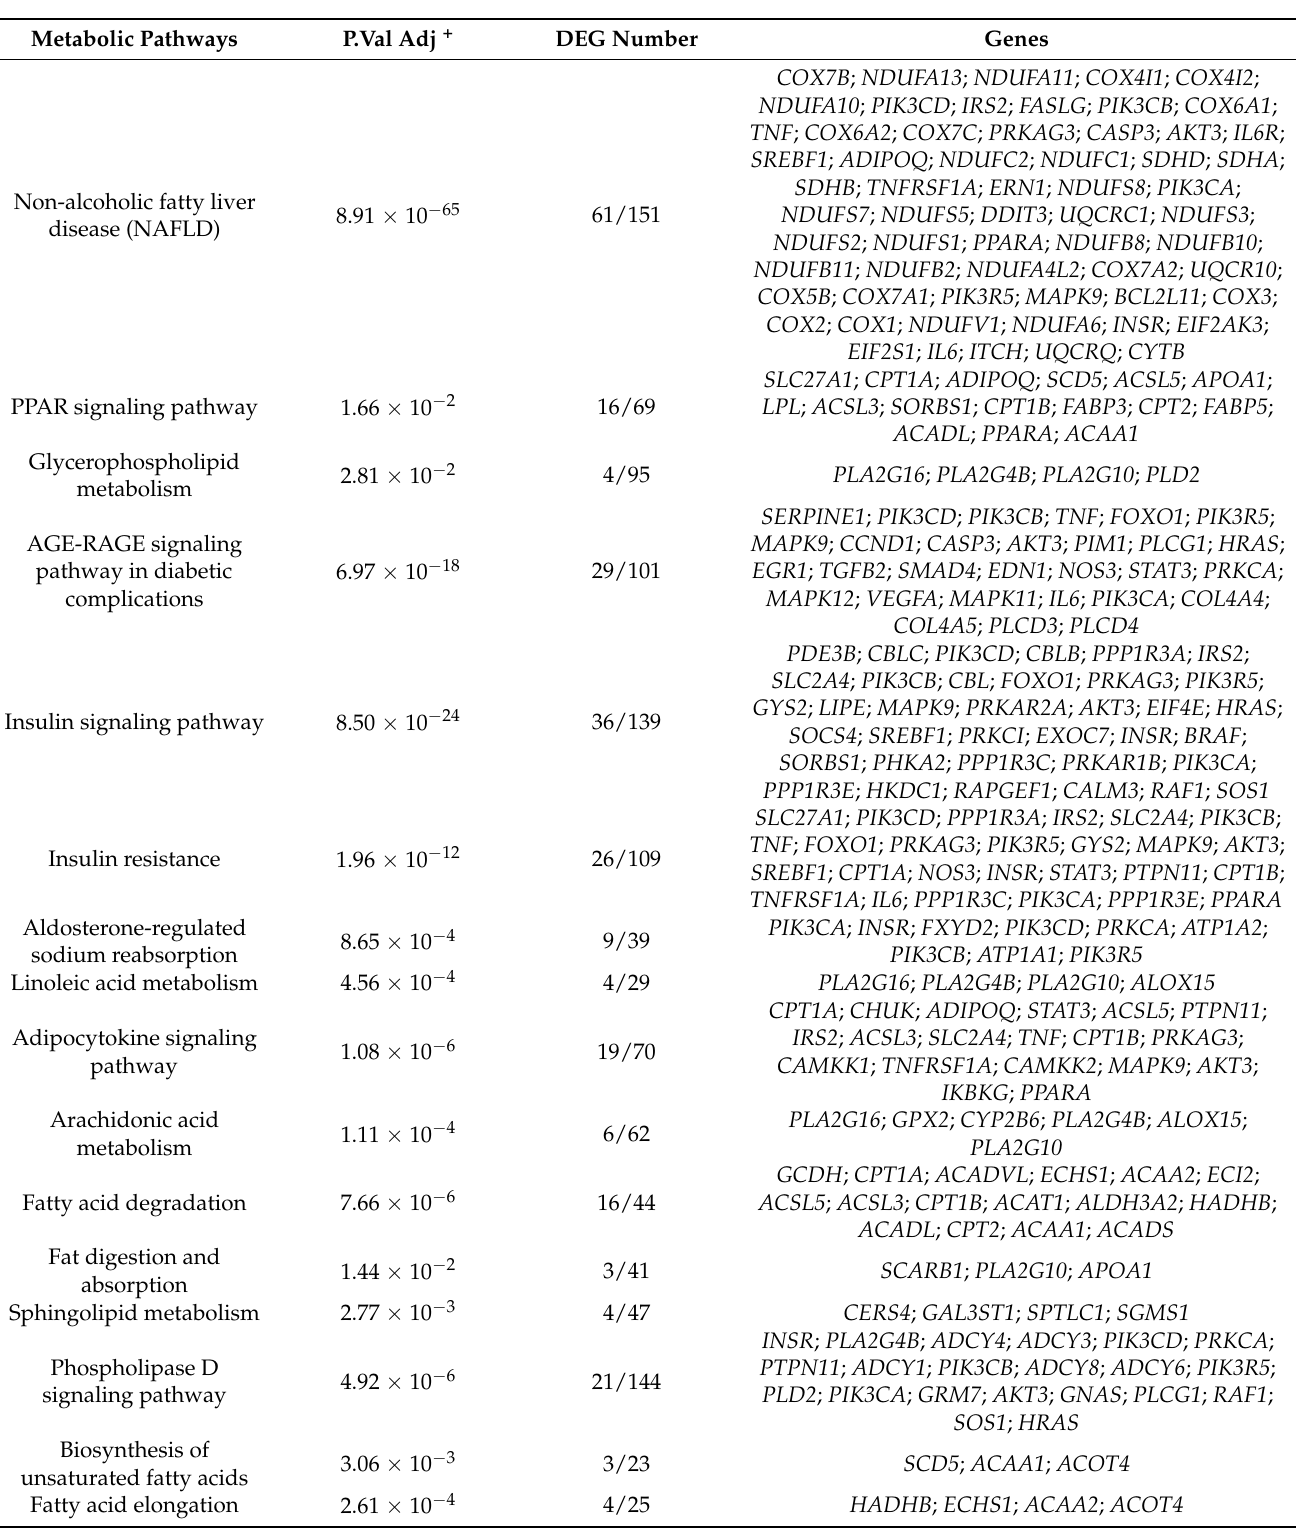
Table A1. Metabolic pathways associated with lipid metabolism that include differentially expressed genes (DEG) of our study, adjusted p -value by Bonferroni correction (P.Val adj), number of DEGs in each pathway and DEG